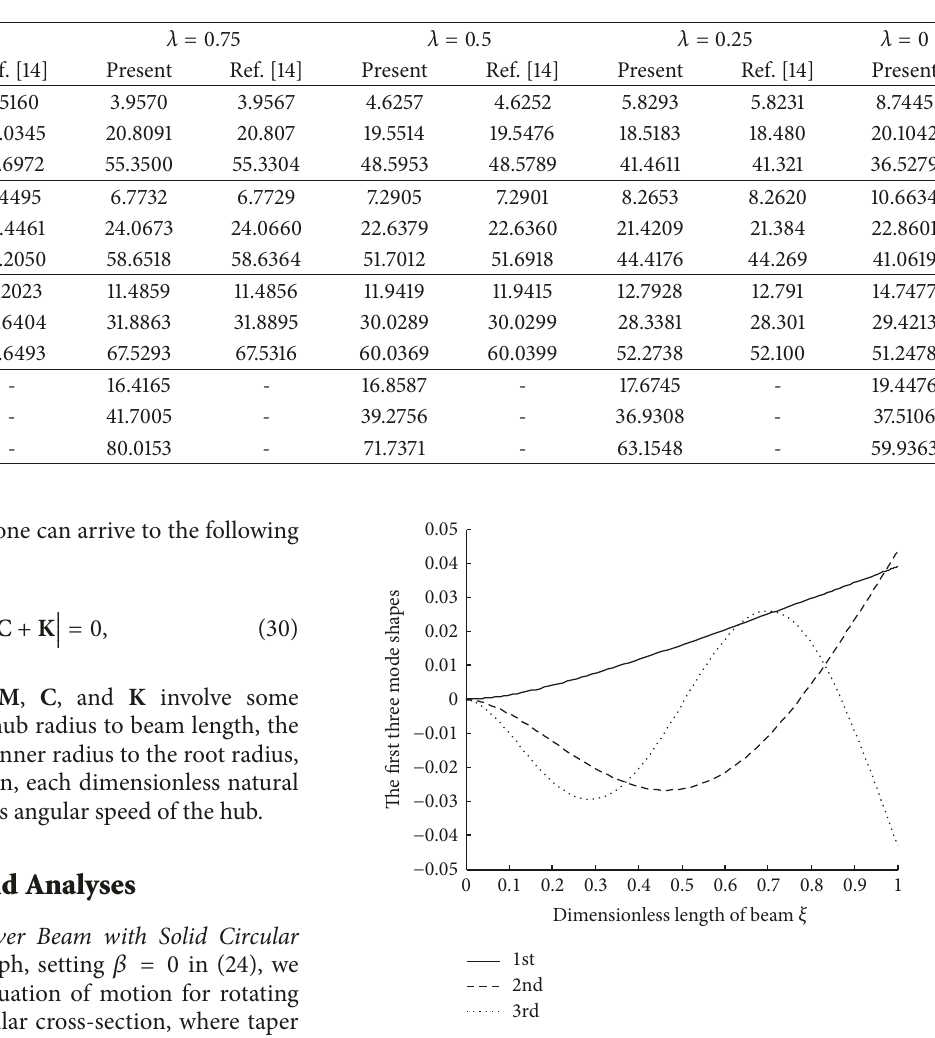
Figure 5: The first three dimensionless mode shapes for 𝜔 = 10 , 𝜆 = 1 , 𝑟 = 0 , 𝛽 = 0 , and 𝑟 = 0 0